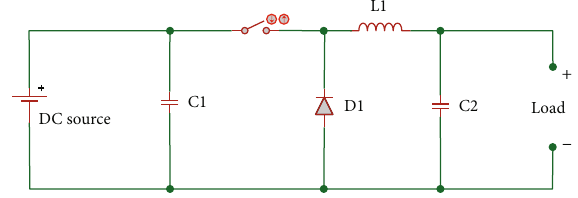
Figure 3: An asynchronous buck converter circuit.